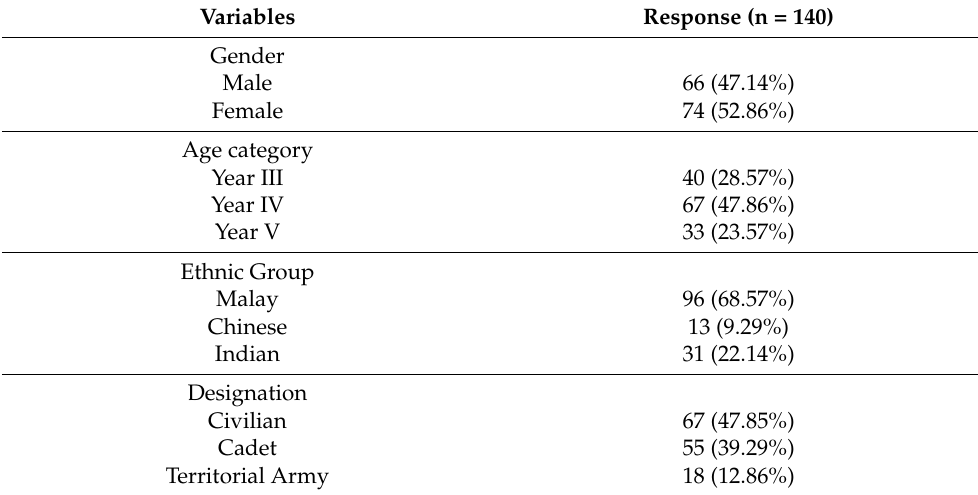
Table 1. Demographic distribution of the